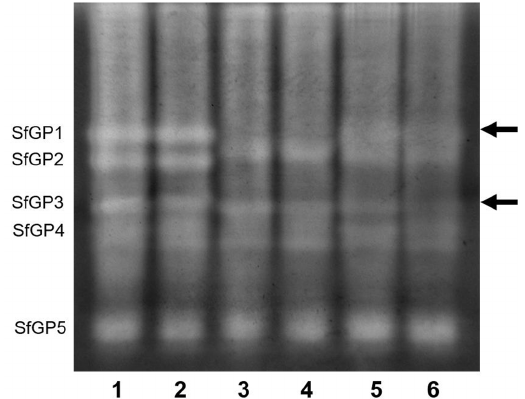
Figure 4. Peptidase activity of midgut peptidases in zymography gel electrophoresis. Samples fed with control diet or diet containing 0.5% talisin were used for the determination of enzyme profile. The bands were designated SfGP1 through SfGP5. Lane 1 was loaded with midgut juice extract from larvae fed on a control diet devoid of talisin; lane 2, with midgut juice extract from larvae fed on a 0.5% talisin diet; lanes 3 and 5, with midgut juice extract from larvae-fed control diets mixed with TLCK and talisin, respectively; lanes 4 and 6 with midgut juice extract from larvae fed 0.5% talisin diets mixed with TLCK and talisin,